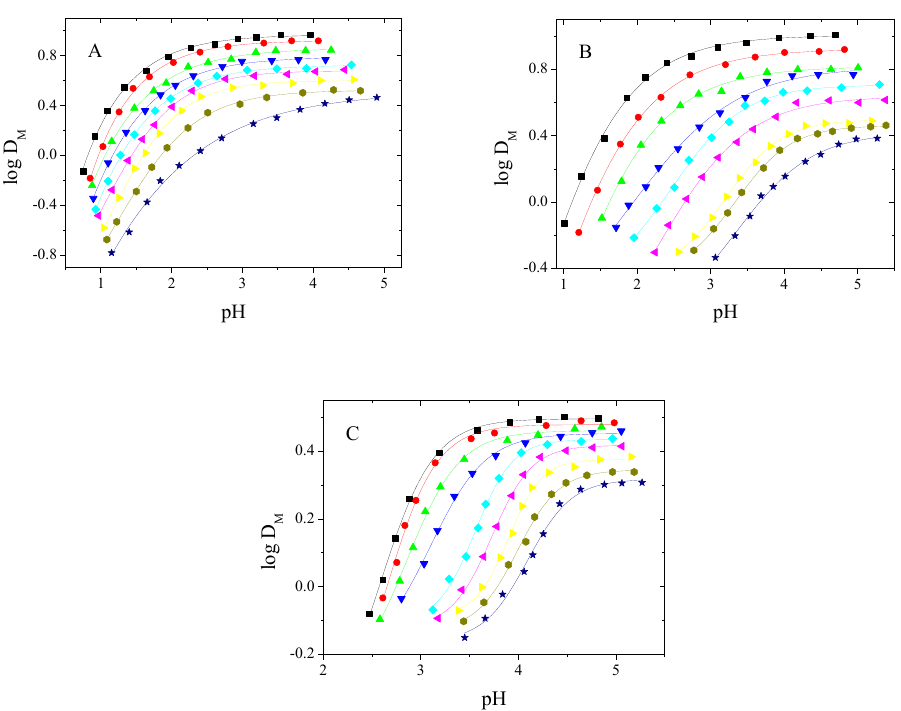
Figure 1. Extraction curves (log D M = f (pH)) of Pd(II) ( A ), Zn(II) ( B ) and Ni(II) ( C ) complexes. (cid:70) - 1 , - 2 , - 3 , - 4 , ◆ - 5 , ▼ - 6 , ▲ - 7 , ● - 8 , ◼ - 9 .